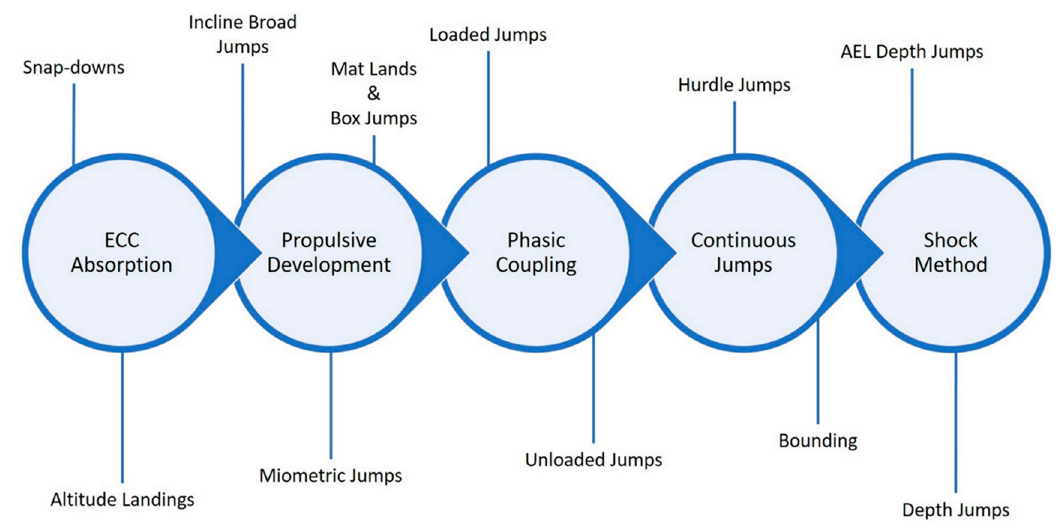
Figure 5. Plyometric training phasic goals and associated exercises.